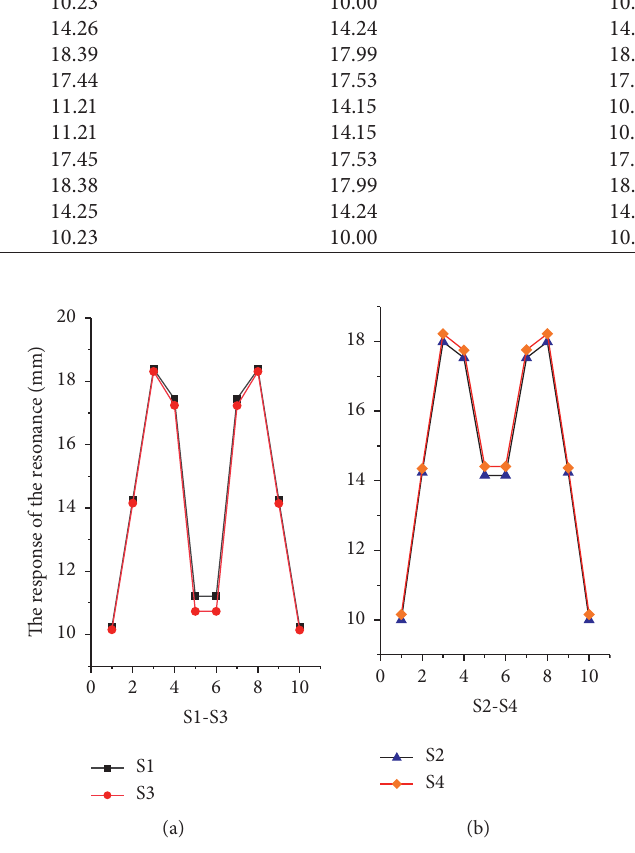
Figure 14: The difference of resonance response under comparison working